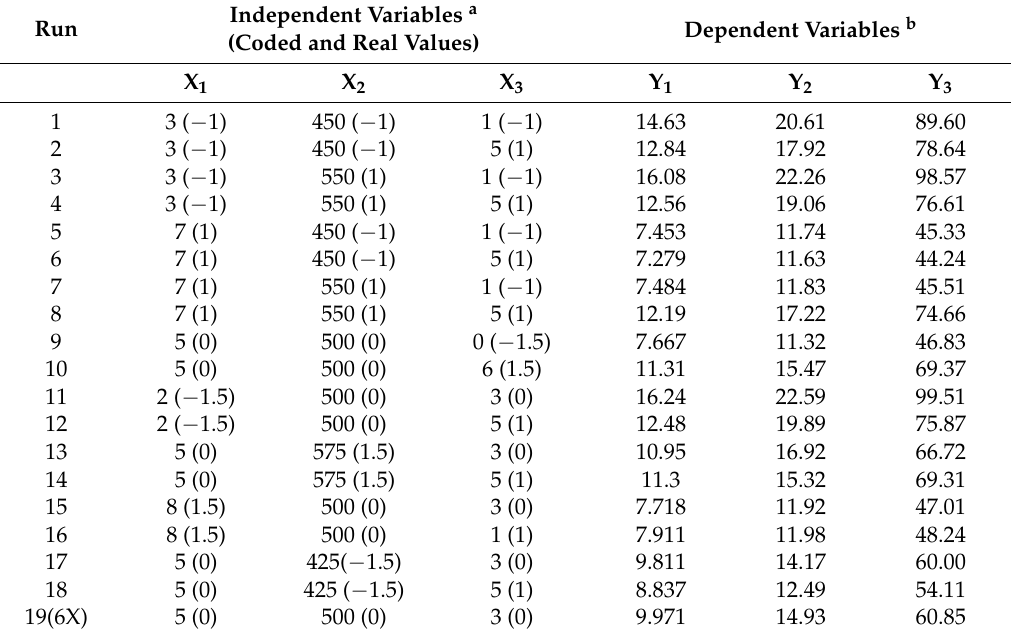
Table 1. 3-variable, 5-level central composite design and responses of dependent variables to the dynamic rheological properties of pressure treated protein enriched mango